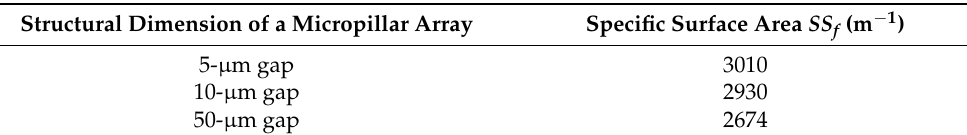
Table 4. Specific surface areas calculated using Equation (5).